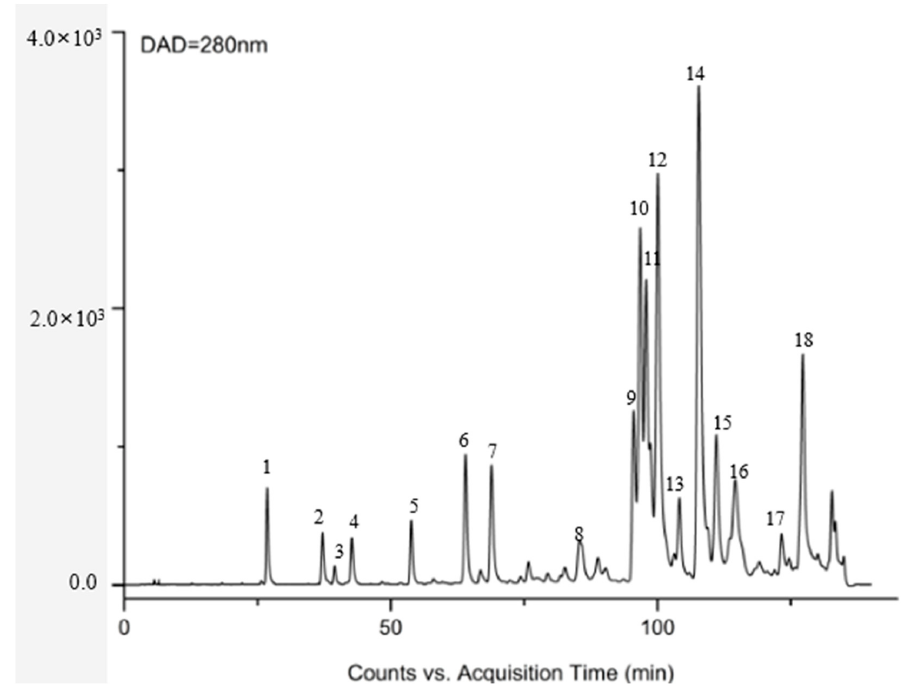
Figure 1. DAD chromatogram at 280 nm of propolis.